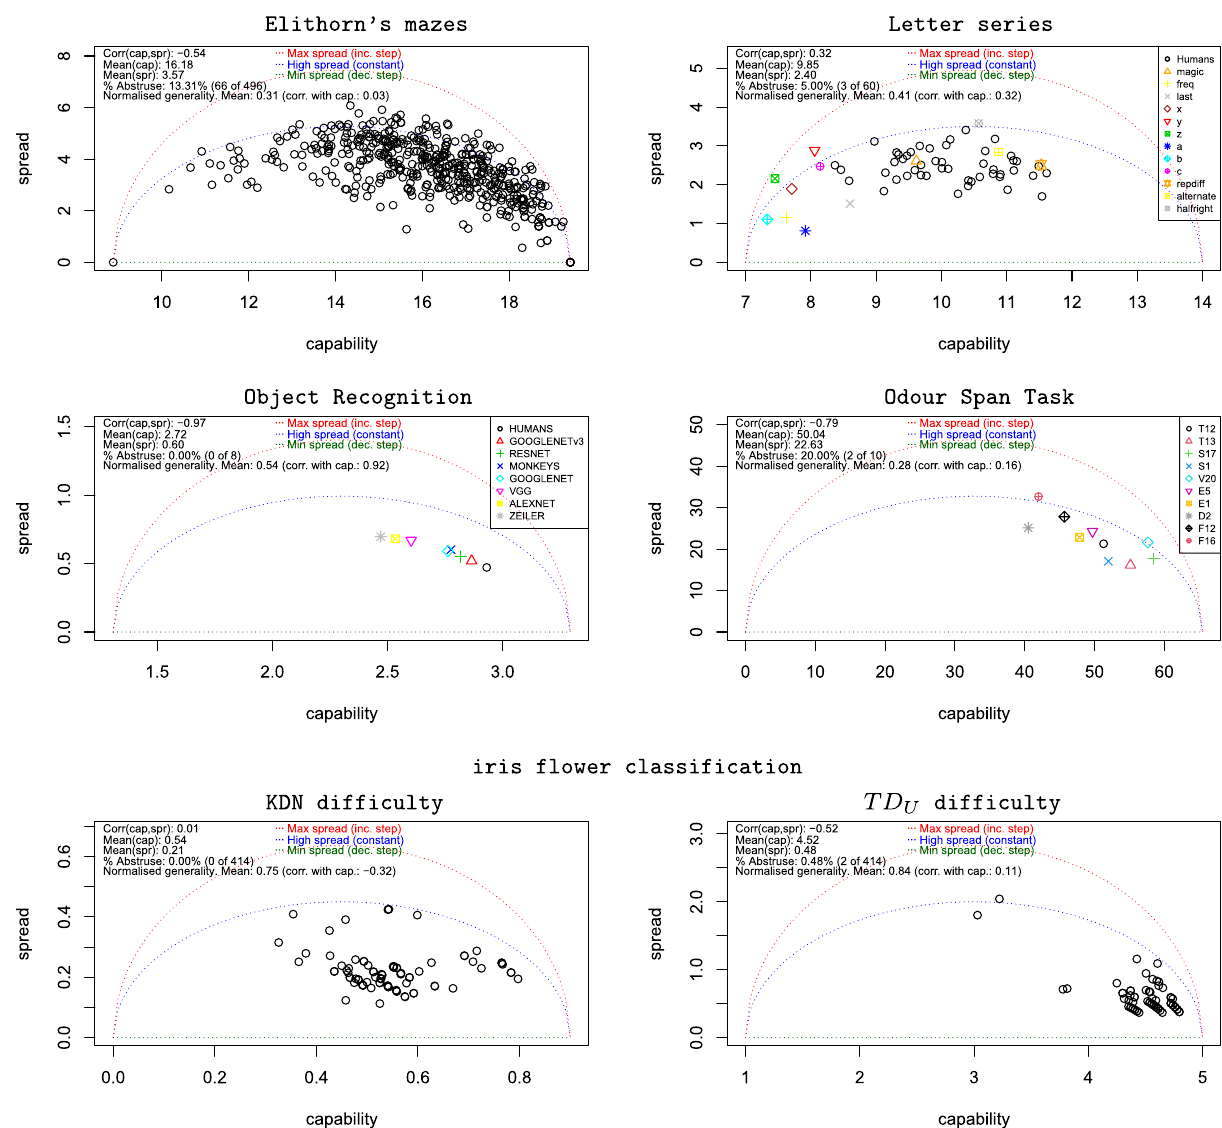
Figure 4. Capability vs spread for the intrinsic difficulties scenarios. The space is characterised by three normalised generality isometrics shown as dotted curves: the maximum spread in red (complete abstrusity), the minimum spread in green (complete generality) and a middle case where results are independent of difficulty (constant ACC). Top left: Elithorn’s mazes. Results for all 496 participants. Top right: letter series for all participants (48 humans and 12 machines). Middle left: object recognition scenario using the intrinsic difficulty derived from the psychophysical parameters). Middle right 10 rats in the Odour Span Task, with difficulty being the number of scents to remember. Bottom: iris classification problem using 419 classifiers from study 7306 in OpenML (after classifiers with accuracy below 0.35 removed). Left, capability vs spread using KDN difficulty 10 ). Right: using TD ( k U difficulty =